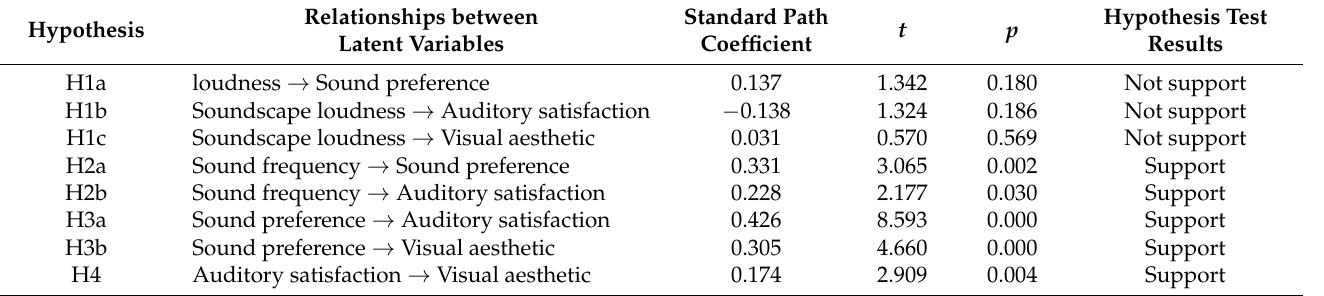
Table 5. Model fitting results.